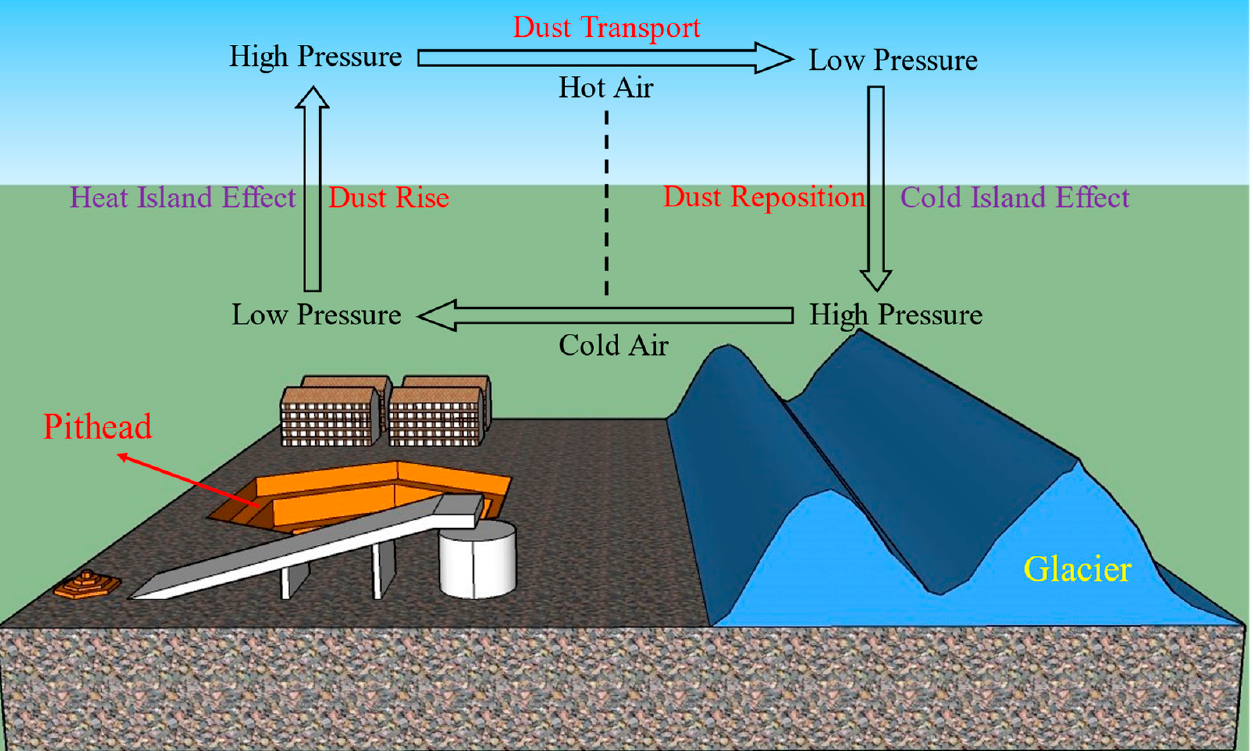
Figure 8. Local atmospheric circulation model under the ‘heat and cold double-island effects’.